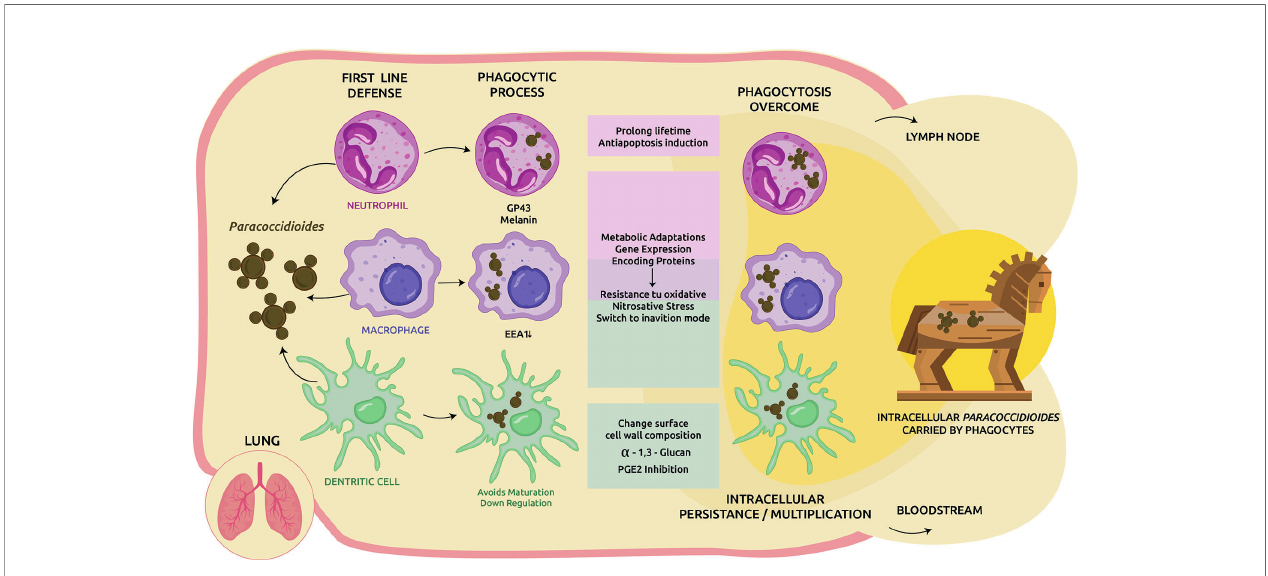
FIGURE 1 | Cellular response to Paracoccidioides infection in the lung and immune-evasion mechanisms. Upon inhalation the saprophytic form converts to the yeast-like parasitic and trigger the host cellular immune response. Phagocytes are motivated to clear the invasive fungi. In addition to its own structural virulence determinants such as gp43, melanin, among others, Paracoccidioides spp. applies several strategies to overcome the host harsh environment, including: modulate host apoptosis, metabolic adaptations, and expression of genes to achieve an inanition mode and also resistance to the host oxidative burst. When intracellular survival is possible, part of the phagocytosed fungi could be transported by DCs/macrophages to lymphoid tissues or other organs via circulation as facultative intracellular pathogens but protected by phagocytes (Trojan horse